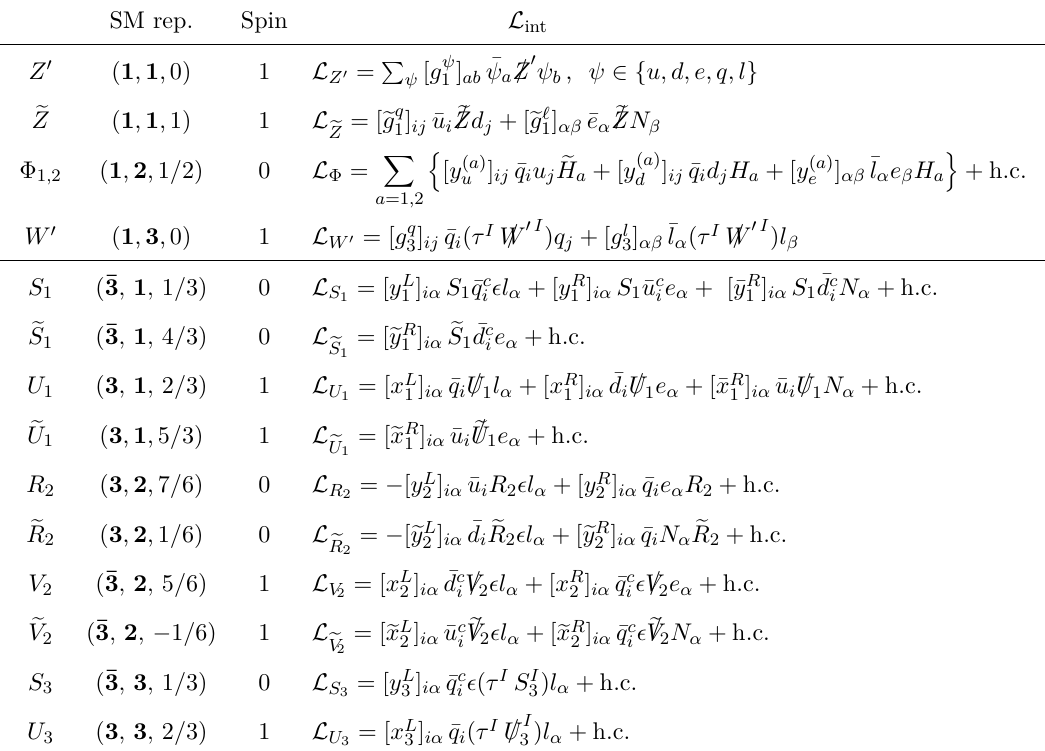
Table 2. Possible bosonic mediators contributing at tree level to Drell-Yan production classified by their SM quantum numbers and spin. In the last column, we provide the interaction Lagrangian ¯ where (cid:15) ≡ iτ , ψ c ≡ iγ ψ T and e H = iτ 2 H ∗ is the conjugate Higgs doublet, where τ i ( i = 1 , 2 , 3 ) 2 2 γ 0 denote the Pauli matrices. The right-handed fermion fields are defined as u ≡ u and N ≡ ν , and the left-handed fermion fields as q ≡ ( V † u R the notation from refs. [55, 56] for the leptoquark